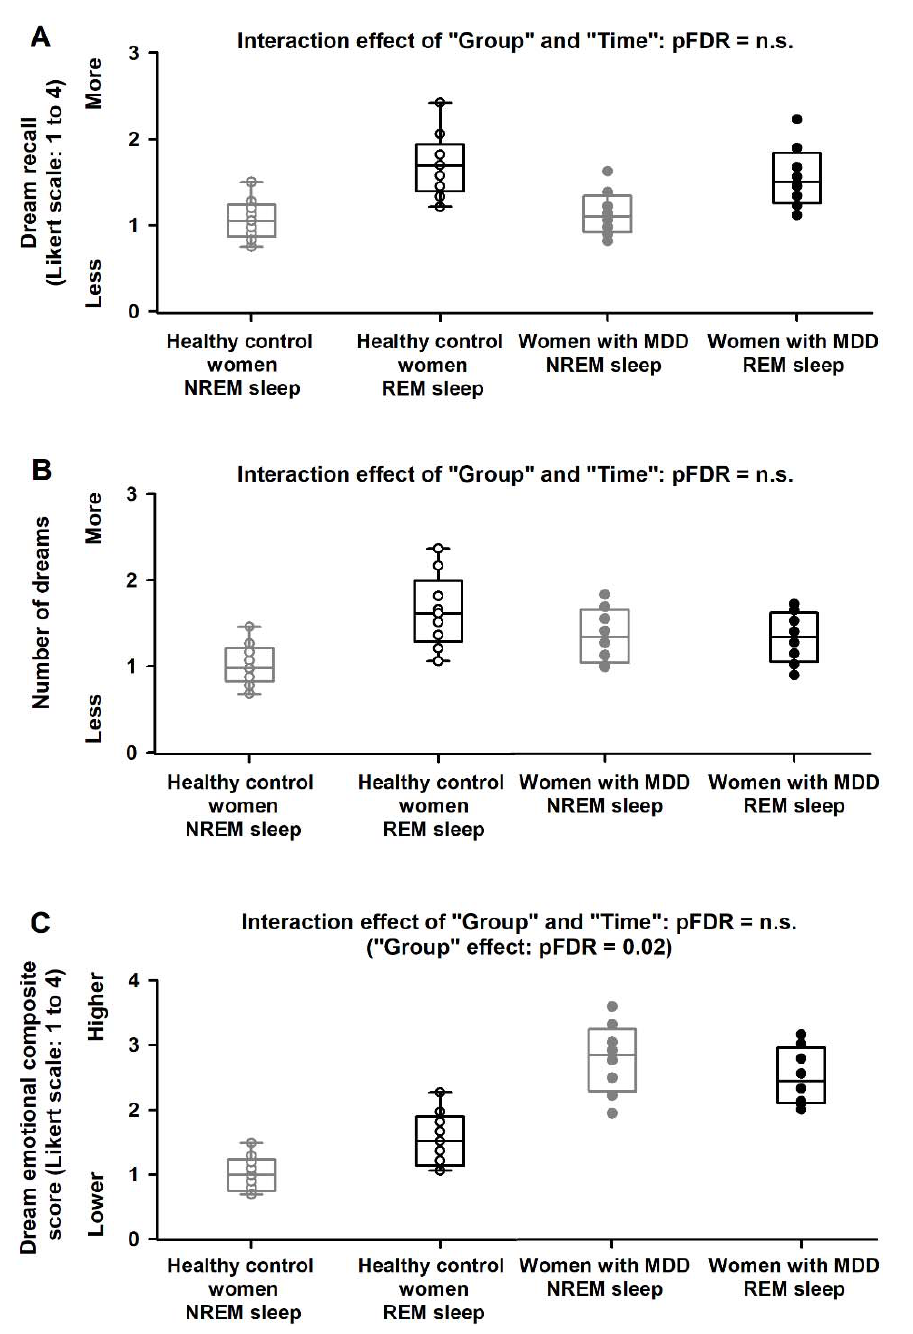
Figure 5. NREM/REM sleep modulation of dreaming in healthy control women and in women with MDD. We observed no significant interaction effects of “Group” and “NREM/REM sleep” for dream recall ( A ) and the number of dreams ( B ). Although we did not observe a significant interaction effect of “Group” and “NREM/REM sleep” for the dream emotional composite score, there was a significant main effect of “Group” ( C ). Accordingly, women with MDD had higher (negative) dream emotional composite score after both NREM and REM naps as compared to the healthy control women. Circles are individual data and boxes are the median and the interquartile range.